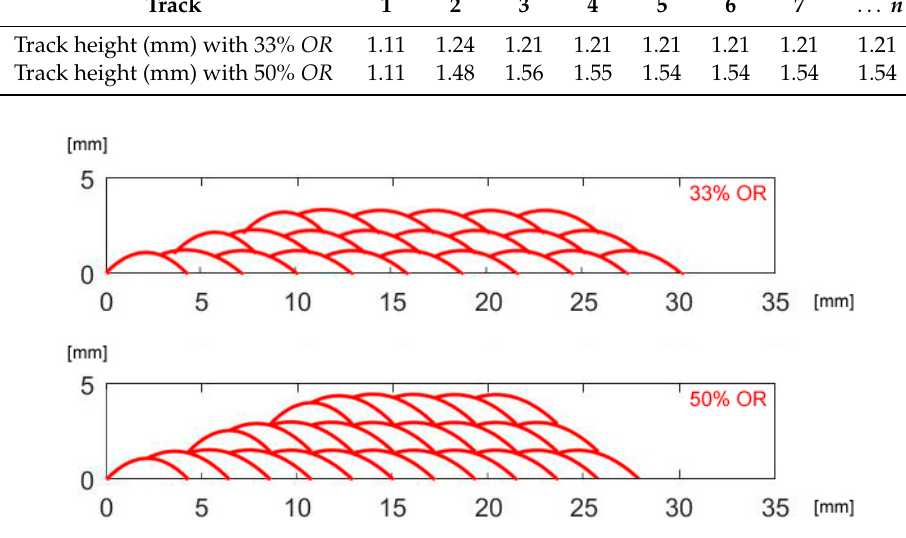
Figure 11 . Multi-track, multi-layer deposition for given OR ; theoretical profiles.